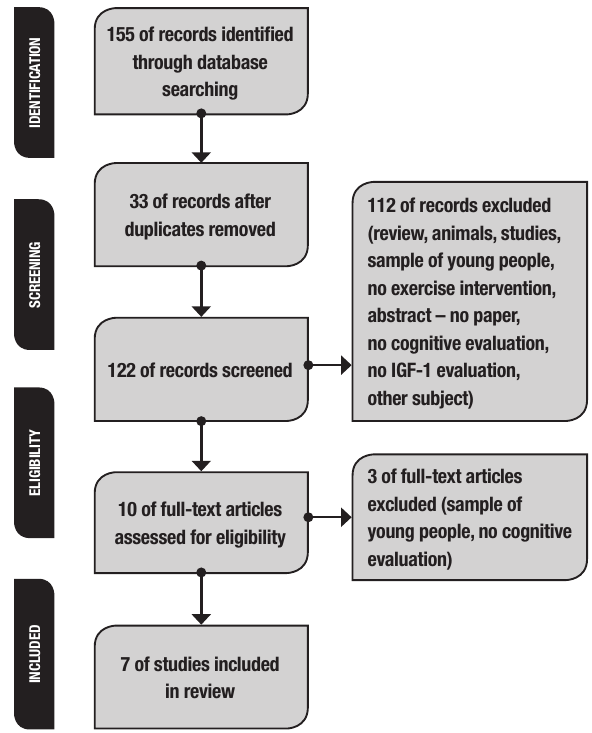
Figure 1. The PRISMA flowchart of the systematic